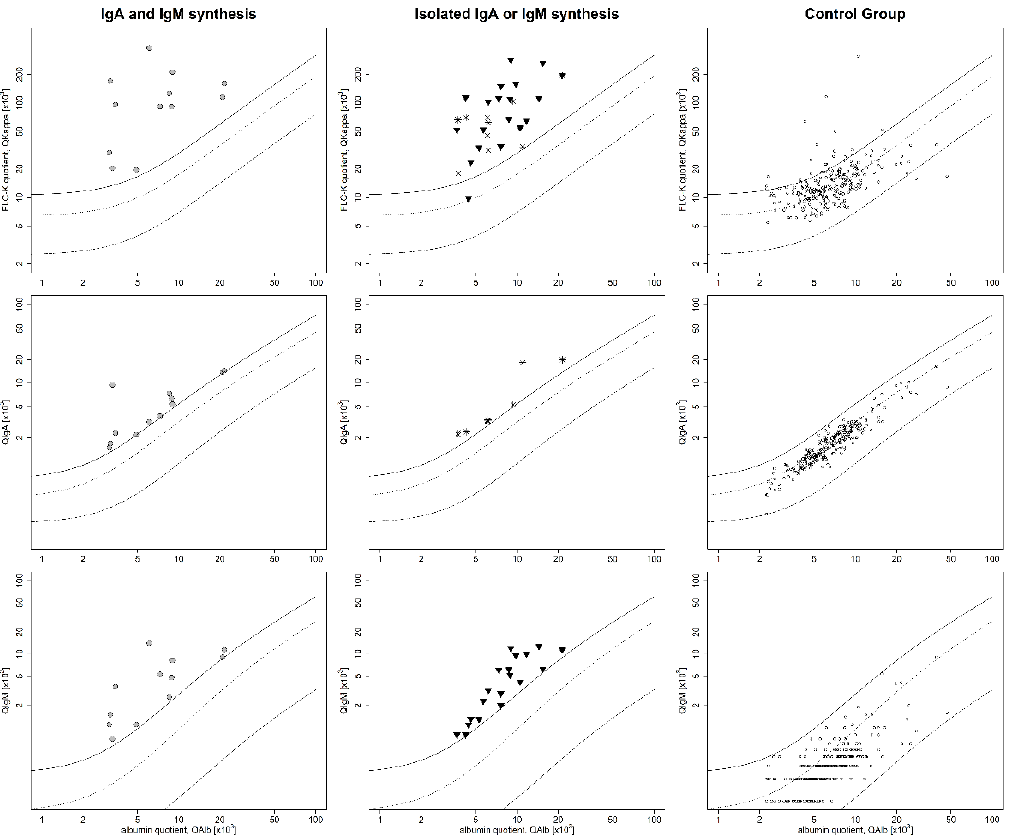
Figure 1. Data of cohort I and the control group in double logarithmic immunoglobulin (Ig)M, IgA, and free light chain kappa (FLC-k) quotient diagrams. The first column includes data from cohort I with combined IgA and IgM synthesis (circles). All FLC-k quotients are above Qlim –FLC-k. Column 2 contains the data of patient samples with an isolated IgA synthesis (asterisks) or isolated IgM synthesis (triangles). Of the FLC-k quotients, 98% are above Qlim –FLC-k. Column 3 displays the data of the control group (circles), in which 7.9% of the FLC-k quotients are above Qlim –FLC-k. The bold line shows Qlim , the dashed line shows the Qmean . The bottom dashed line shows the Qlow . QLim / mean / low– IgG/IgA/IgM/FLC-k = upper/mean/lower limit of the hyperbolic reference range; IF = intrathecal fraction. Cells 2021 , 10 , x FOR PEER REVIEW